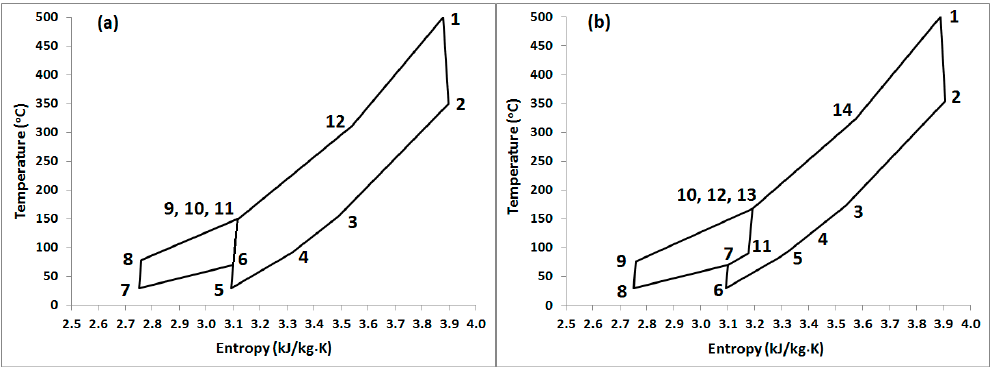
Figure 2. A temperature–entropy diagram for different S-CO 2 Brayton cycle layouts: ( a ) RBC-PC, and ( b ) RBC-PC with improved heat regeneration (RBC-PC-IHR). The highest temperature of the cycle is 500 °C.